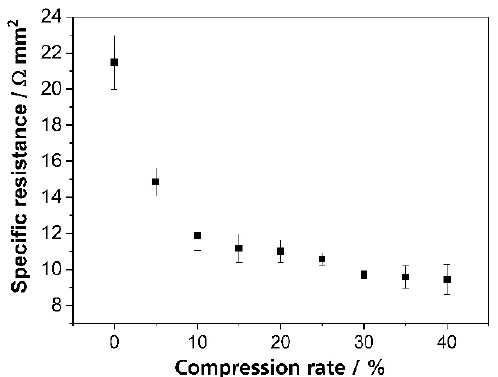
Figure 2. Specific electric resistance of the SIGRATHERM ® GFA5 graphite felt at different compression rates up to 40% of the original thickness. The resistance was measured on a dry 25 cm 2 graphite felt at a total current of 100 mA.